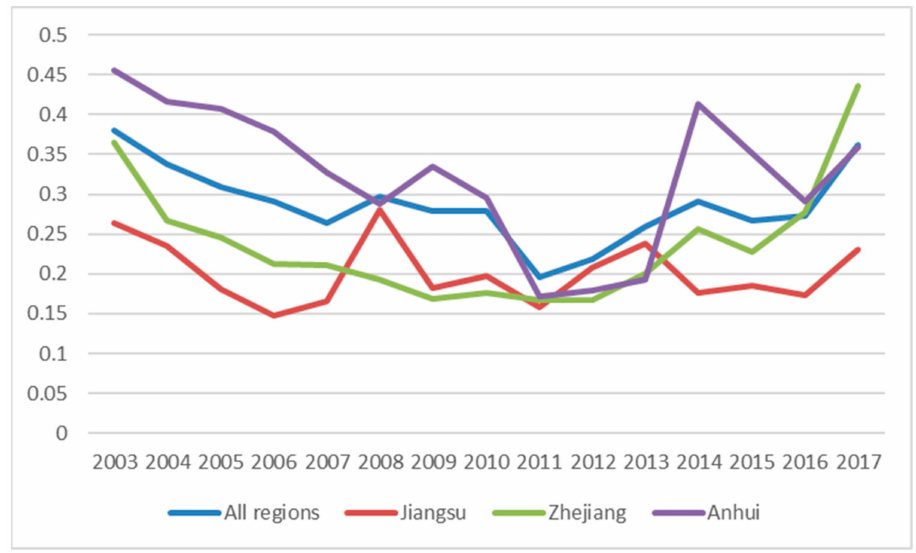
Figure 6. The σ Convergence Index of Each Region.